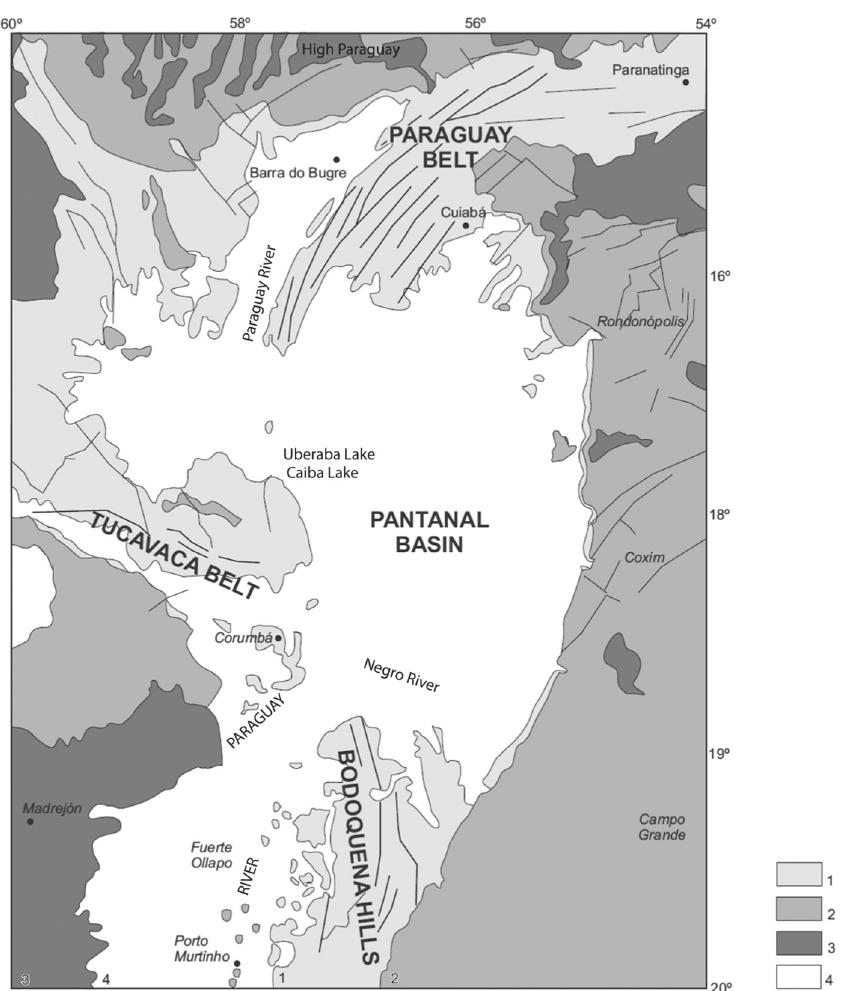
Figure 1 - The geological context of Pantanal in relation to regional tectonic units (simplified from Schobbenhaus and Bellizzia 2001): (1) Precambrian metamorphic rocks; (2) Gondwana sequence with Paleozoic sedimentary rocks; (3) Tertiary sedimentary rocks, and (4) Cenozoic sequences including Pantanal. It is important to observe the structural context with the metamorphic rocks of Paraguay Belt to the north; Bodoquena Hills to the south, composed by carbonates and other metamorphites; the Paraná Basin to the east, and Precambrian rocks of the Tucavaca Belt and Bolivian Cenozoic sediments to the